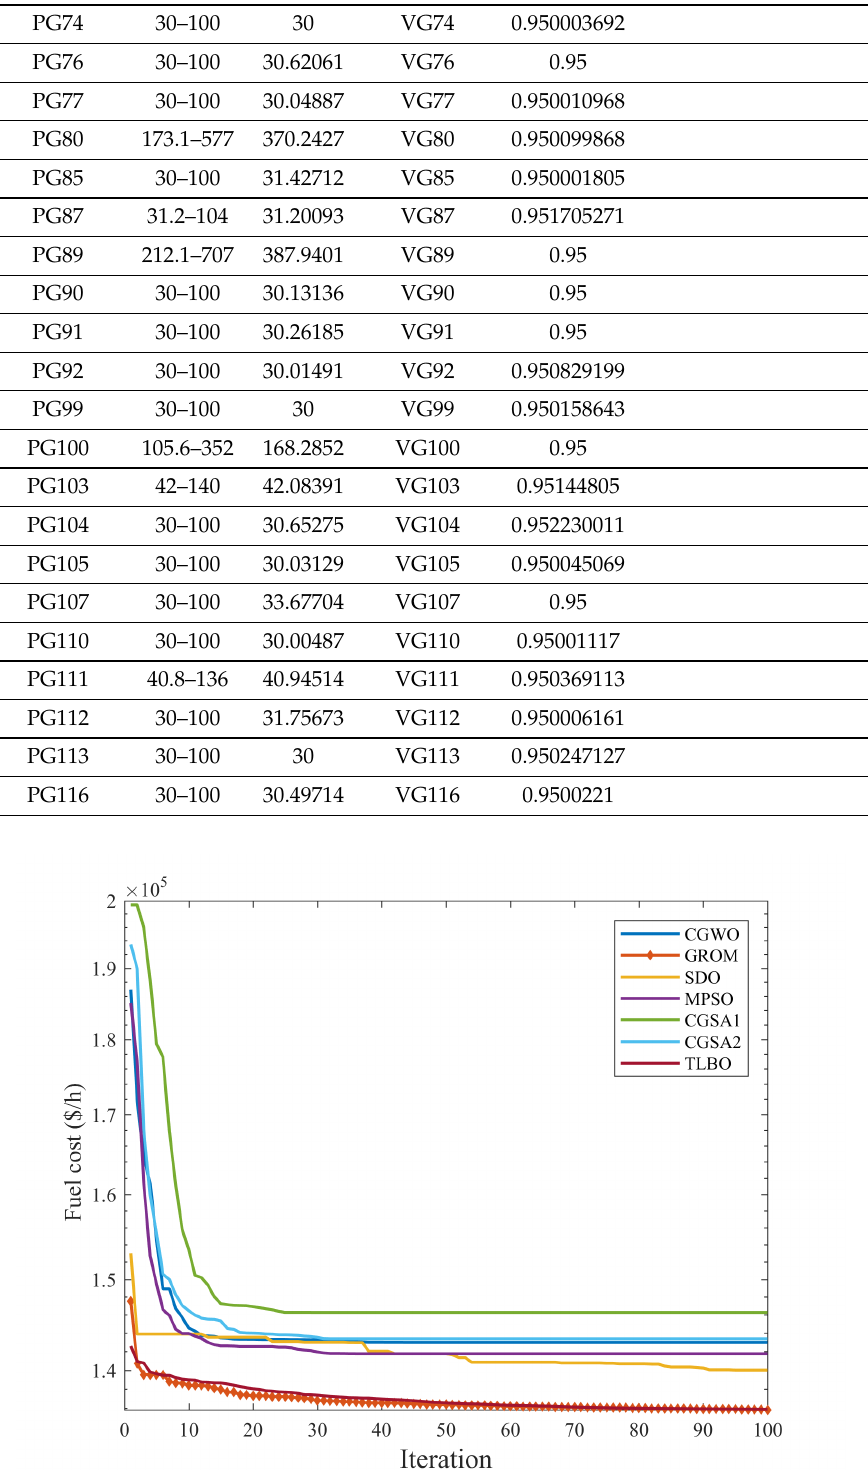
Figure 17. Convergence Curves for IEEE 118-bus